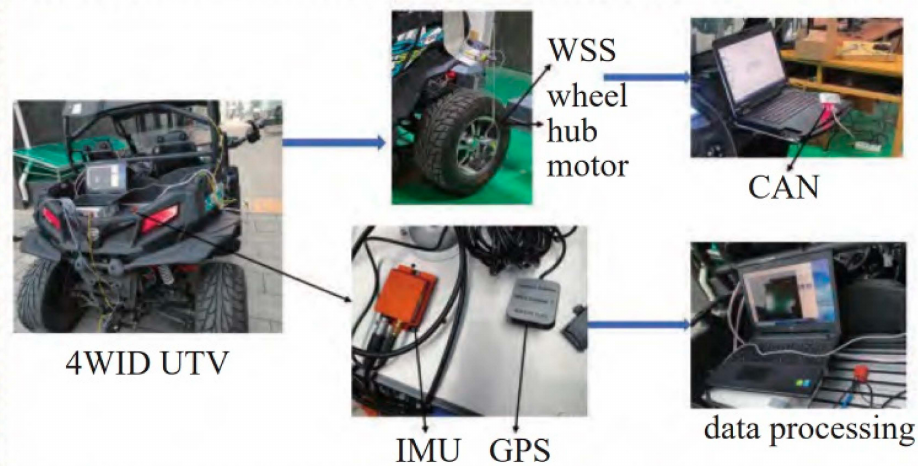
Figure 14. Experimental vehicle and sensor